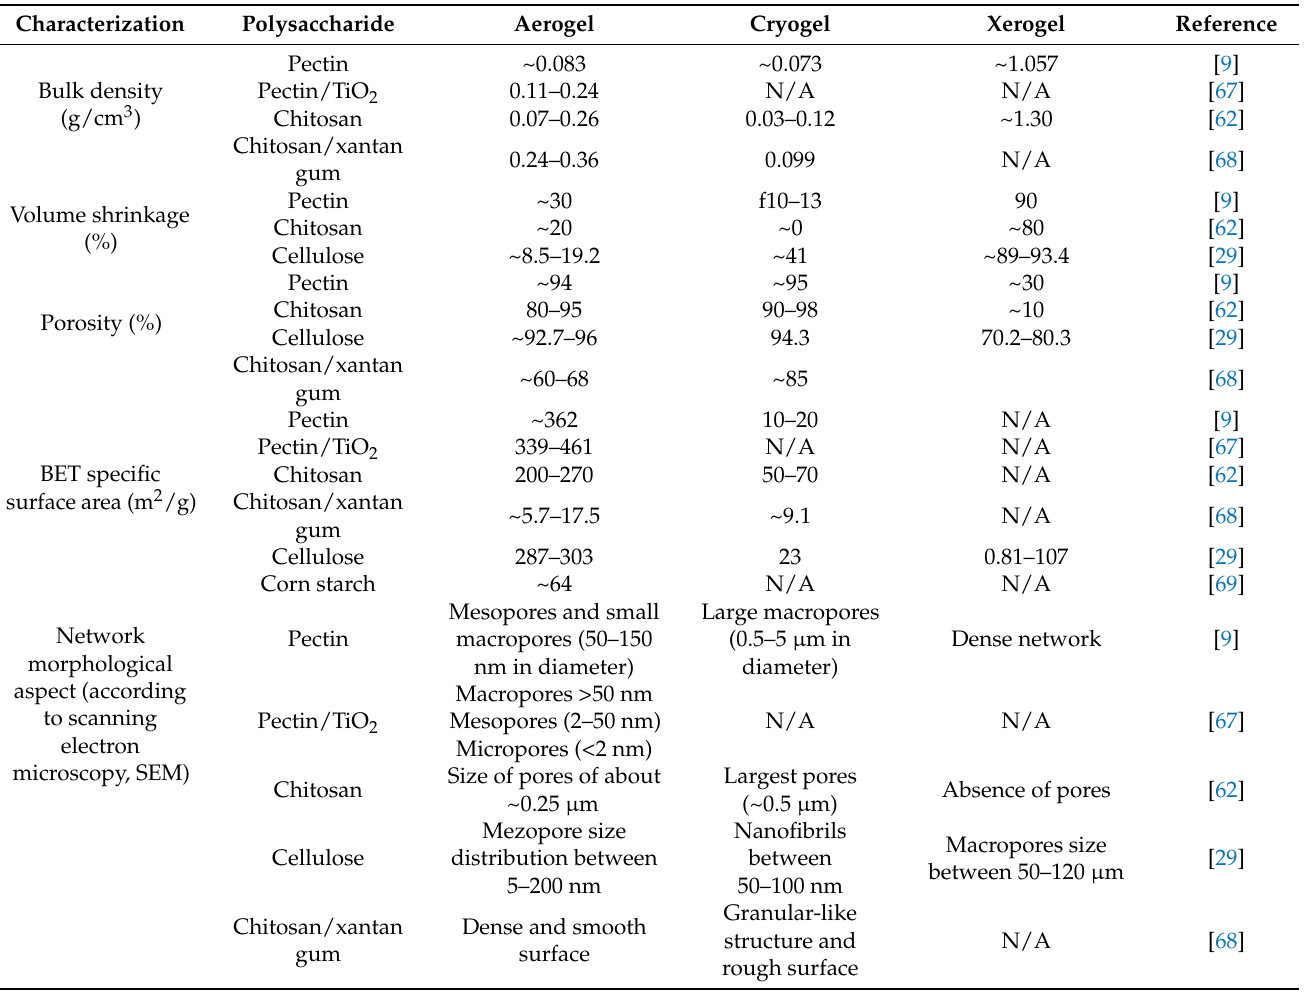
Table 1. Main characteristics of aerogels, cryogels and xerogels,